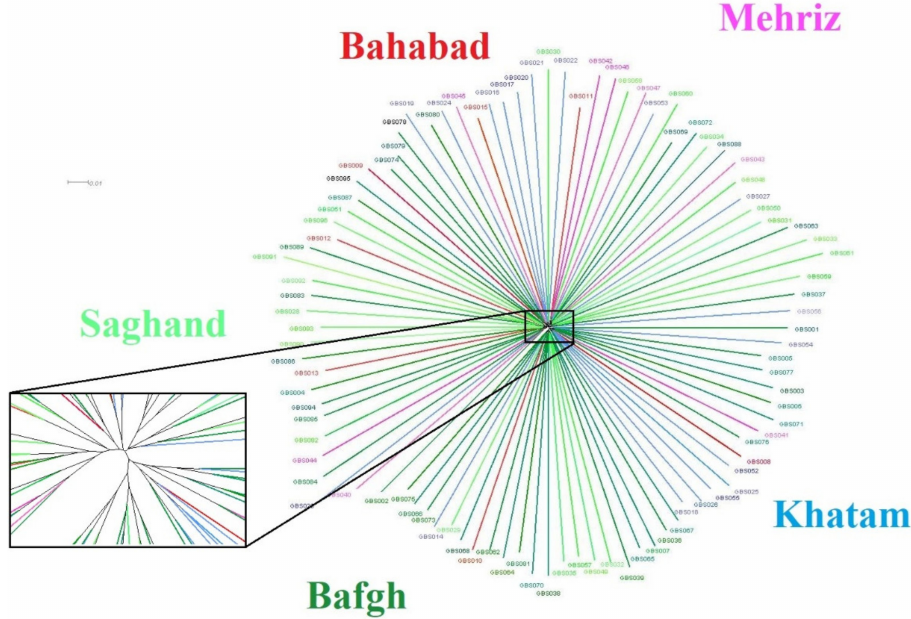
Figure 6. SplitsTree network. Phylogenetic network calculated with SplitsTree using Neighbour-net, with a zoom to visualize the split among five regions of Iran’s central desert.